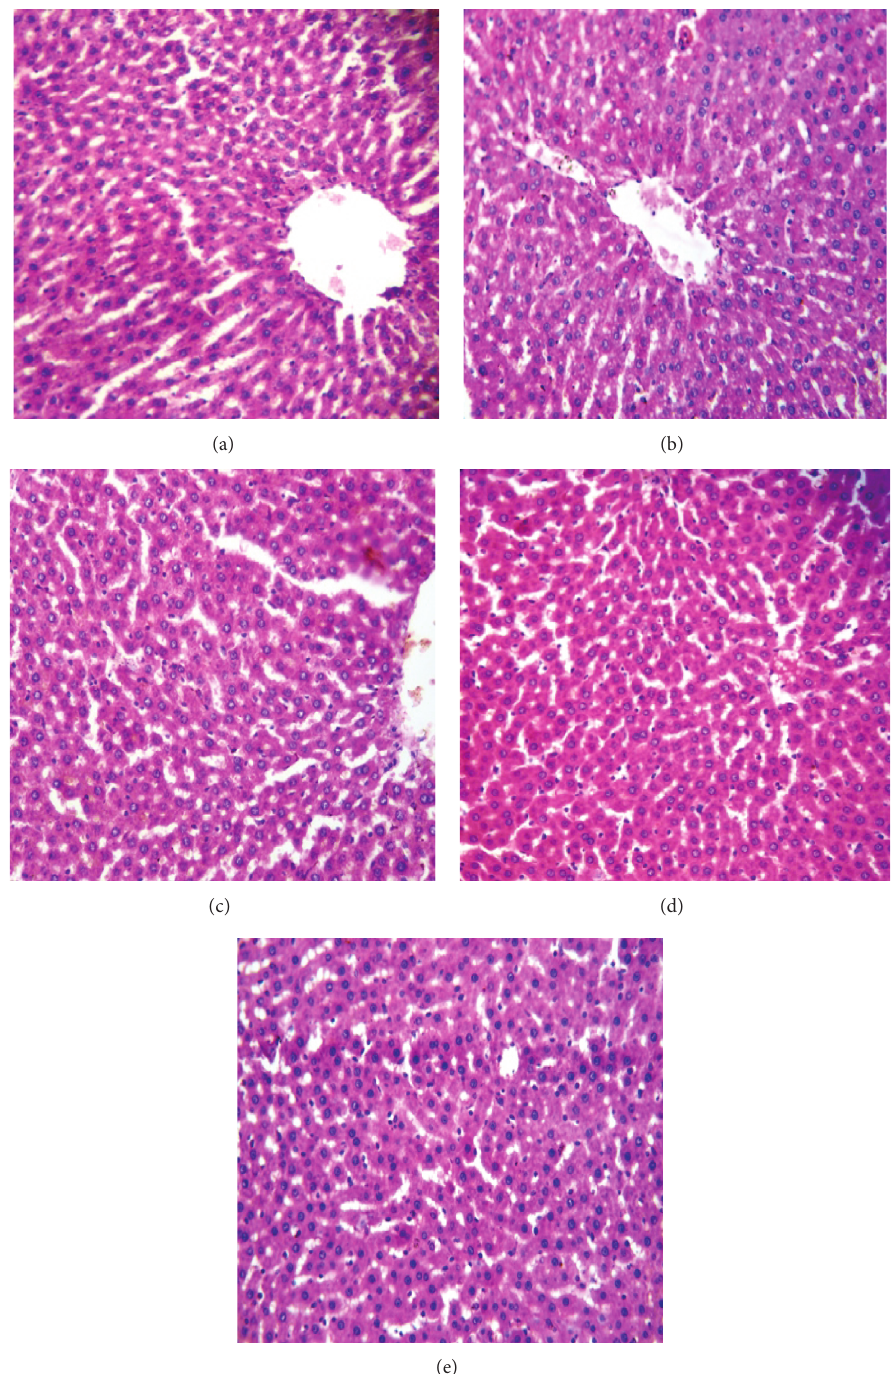
Figure 6: Histopathological changes in liver of control and extract treated groups. (a) Control; (b) ALA; (c) ABA; (d) ALM; (e) ABM.